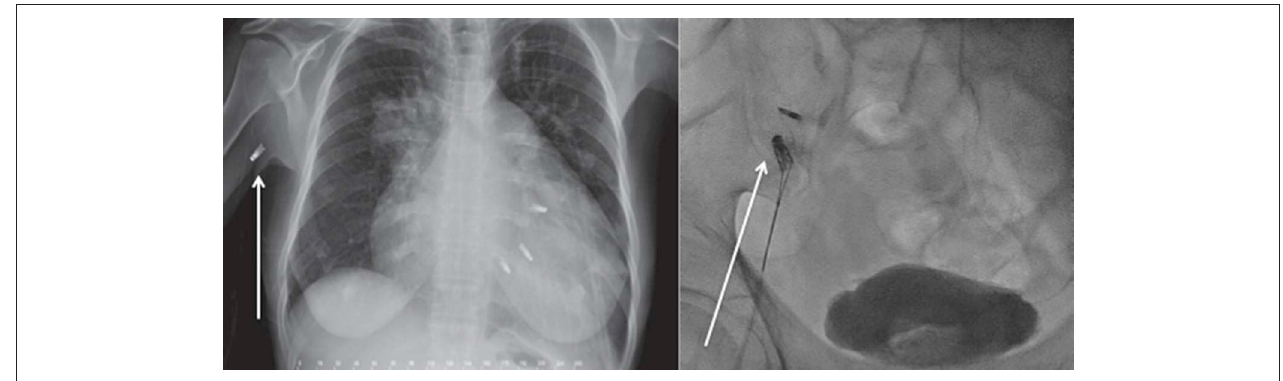
FIGURE 2 | Late Mitraclip embolization. (Left) Clip embolization into the axillary artery Courtesy Dr. Bilge . (Right) Clip embolization into the femoral